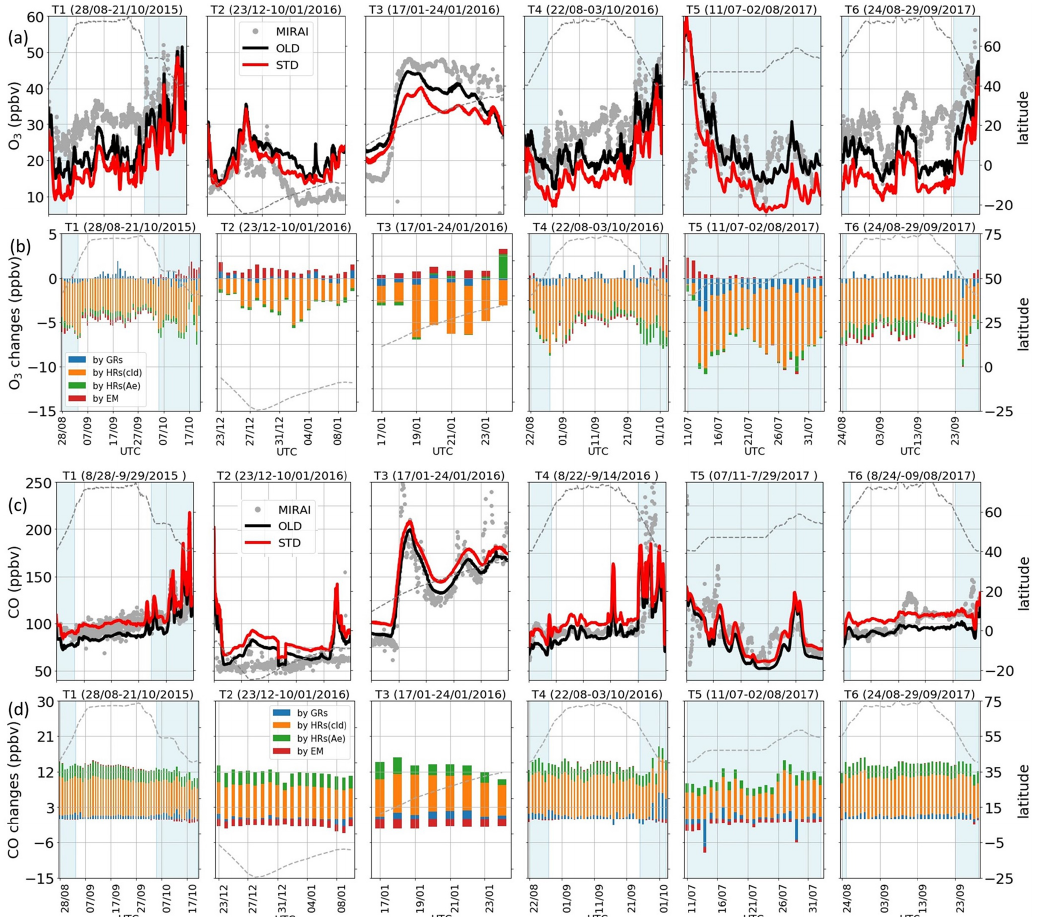
Figure 7. Validation with ship-based data. Observed and simulated concentrations (a, c) and daily mean effects by HONO chemistry (b, d) for O 3 and CO during Mirai cruises. (a, c) Grey dots: observation; black lines: OLD case; red lines: STD case. (b, d) Blue bars: changes by GRs; orange: changes by HRs on clouds; green: changes by HRs on aerosols; red: changes by EM. The left axis exhibits the concentrations and changes (ppbv). The right axis shows cruising latitudes plotted as dashed lines. The horizontal axis is travel times (UTC). Vertical light-blue shaded areas are for data in the NP region (40–60 ◦ N, 140–240 ◦ E).